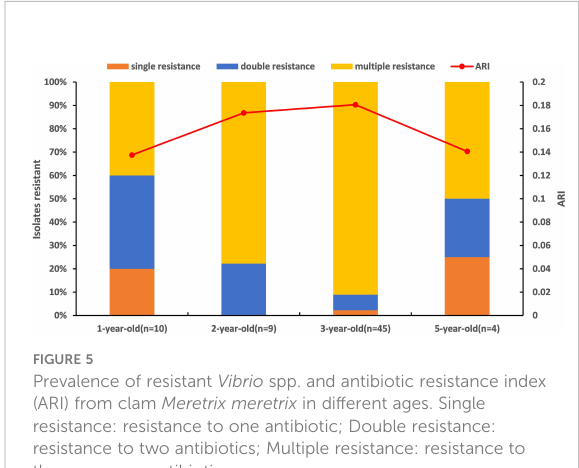
FIGURE 5 Prevalence of resistant Vibrio spp. and antibiotic resistance index (ARI) from clam Meretrix meretrix in different ages. Single resistance: resistance to one antibiotic; Double resistance: resistance to two antibiotics; Multiple resistance: resistance to three or more antibiotics.